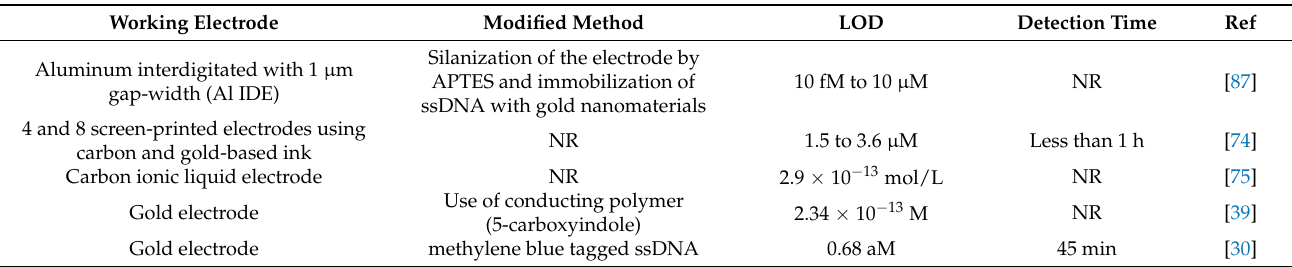
Table 3. Common working electrodes have been used for the detection of